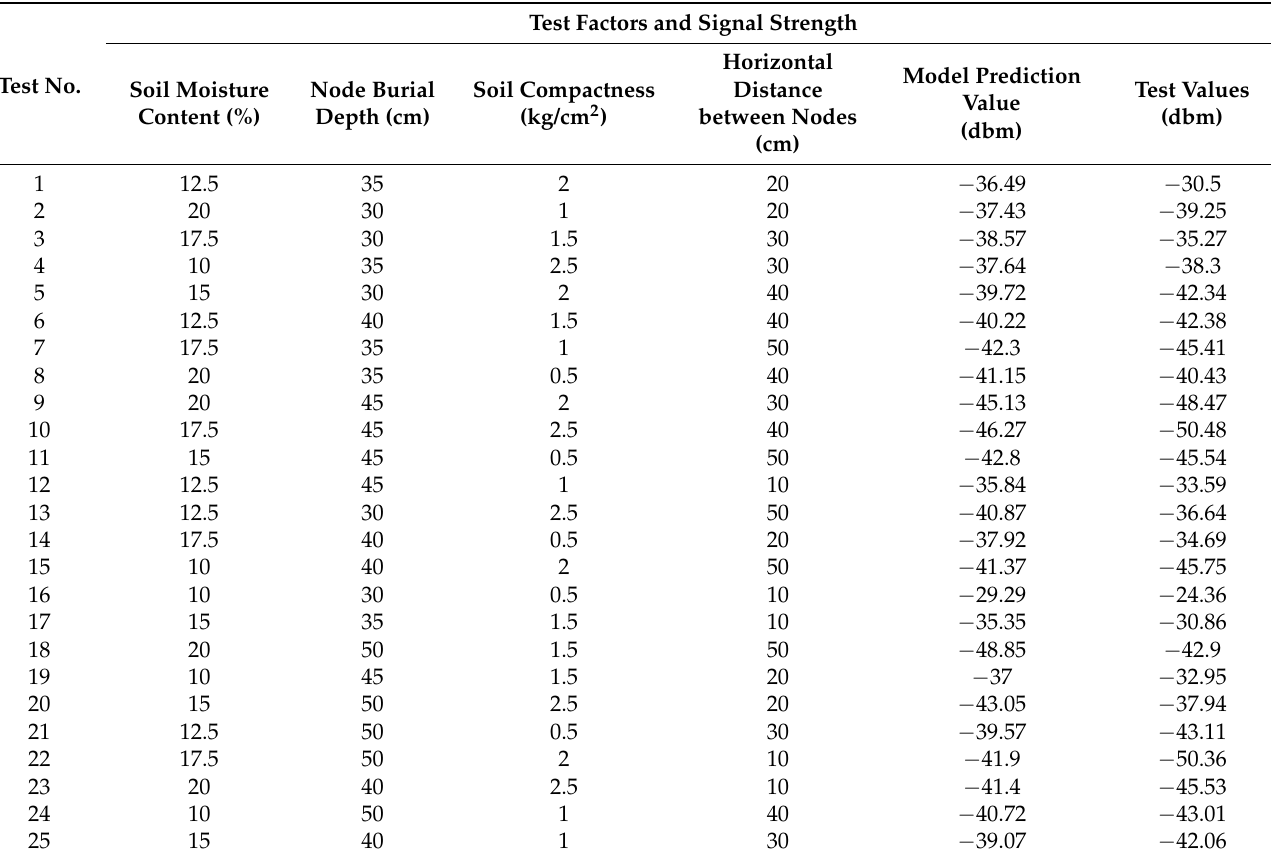
Table 4. WUSN node communication test results influenced by multiple test